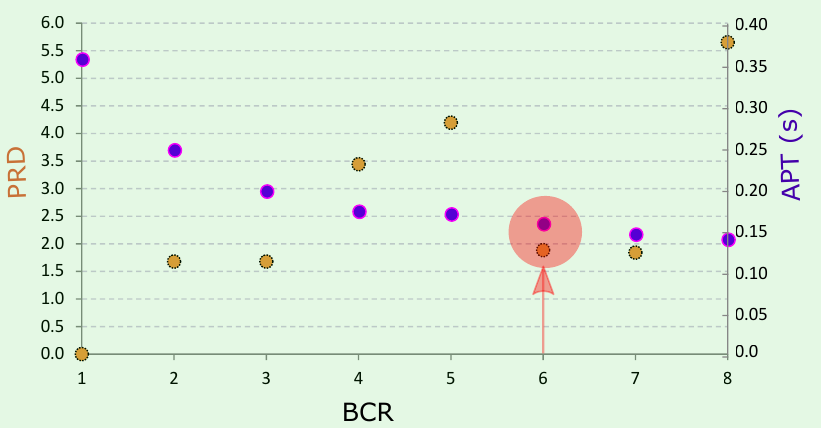
Figure 4. Performance of proposed Method III. Here, BCR stands for bit compression ratio, PRD stands for percentage root-mean-square difference, and APT stands for average processing time. The red arrow shows the optimal combination of BCR, APT, and